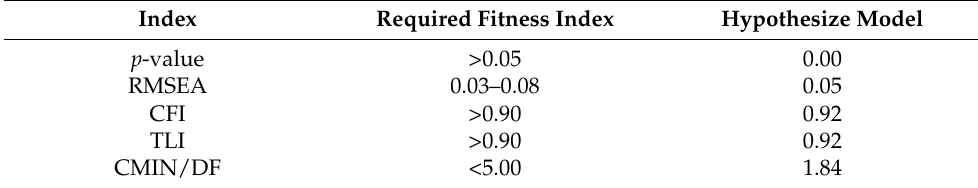
Table 3. Fitness indices of adolescent connectedness.